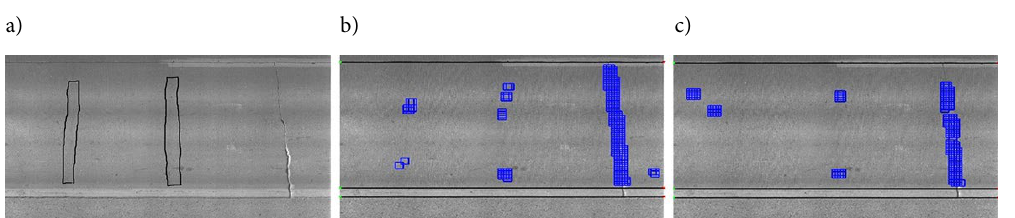
Figure 13. An example of high severity asphalt pavement crack detection: a – actual image; b – shape-based crack detection; c – SVM based crack